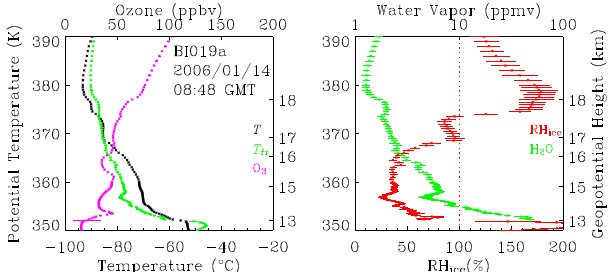
Fig. 12. The same as Fig. 8 but for the launch conducted at 08:48GMT on 14 January 2006. Note that the vertical range is from 350 to 390K rather than 340 to 380K as in Fig. 8. COBALD data are not available at the time of this